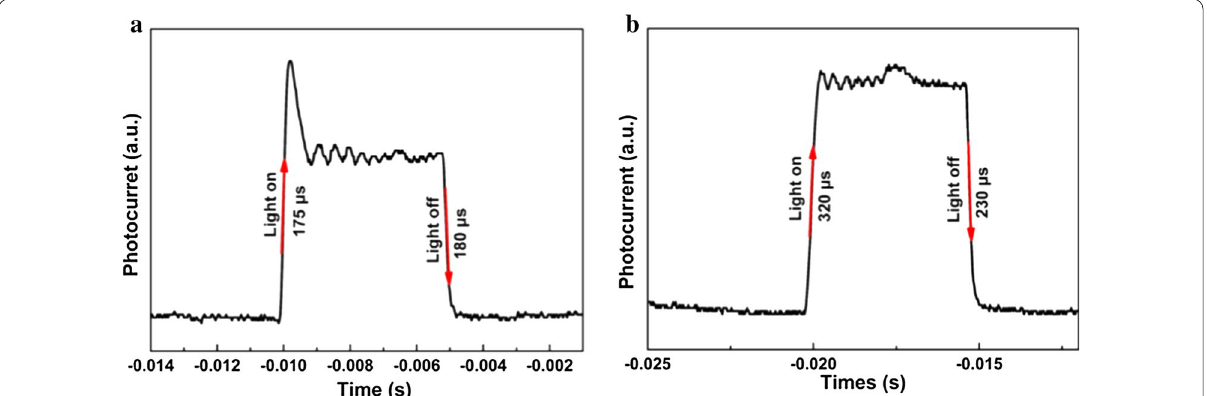
Fig. 5 Response speed of CsPbI x Br 3 perovskite PDs. a CsPbI 2 Br perovskite photodetector, b CsPbIBr 2 perovskite − x